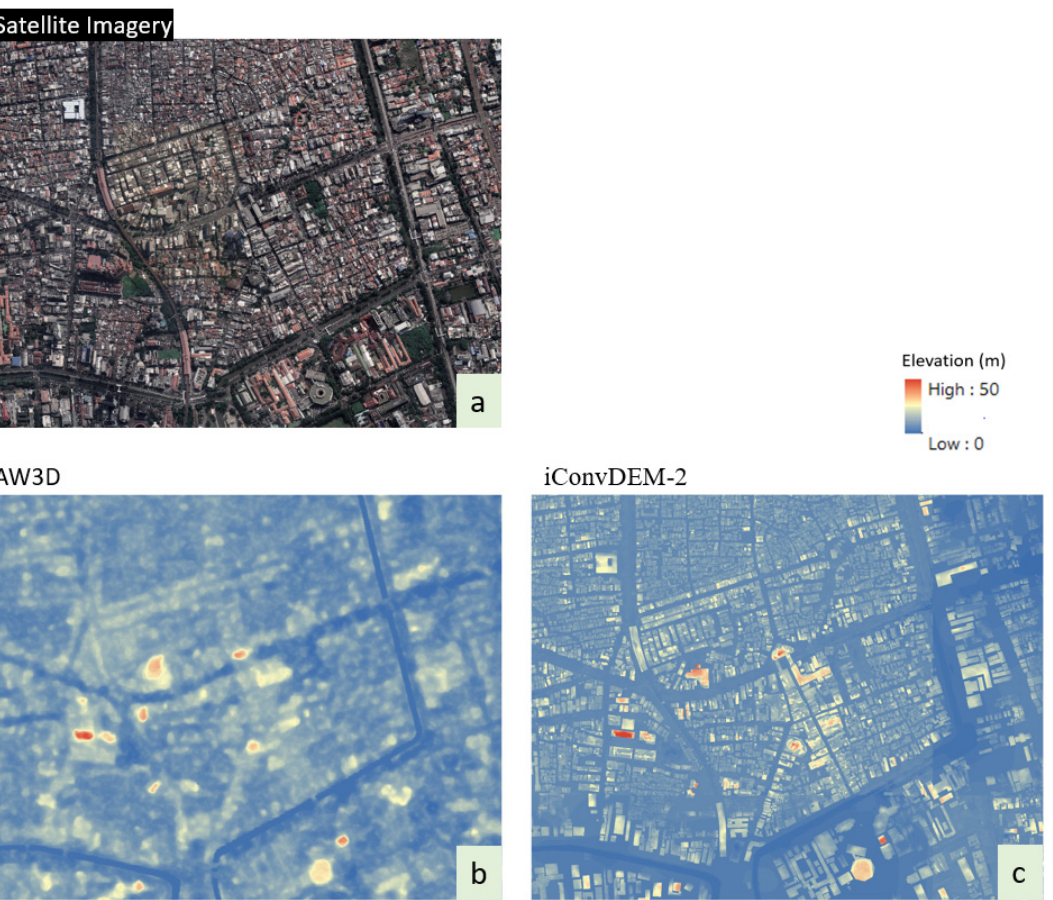
Figure 13. Plots at application site in Jakarta: ( a ) Satellite image, ( b ) SRTM DEM and ( c ) iConvDEM- 2.